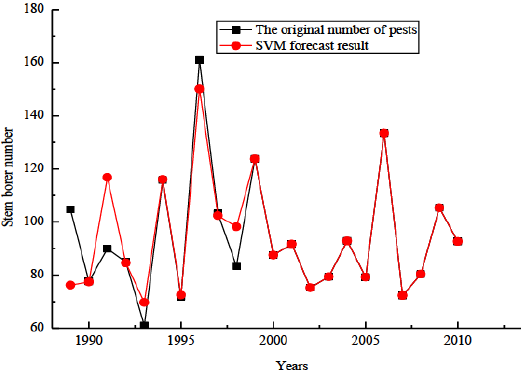
Figure 3: The prediction result of the stem borer number by SVM on training set